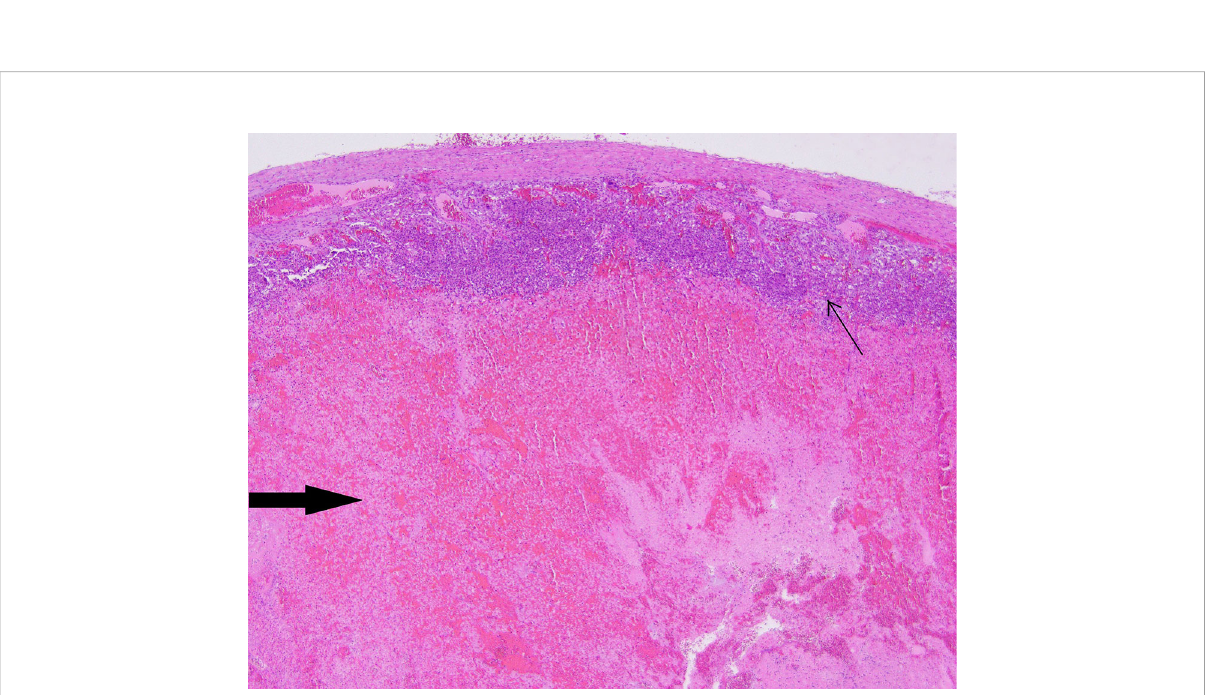
FIGURE 6 Patient number 4: extensive, diffuse hemorrhage in the central part of the pheochromocytoma (thick arrow), the neoplasm ’ s tissue is present as subcapsular narrow rim (thin